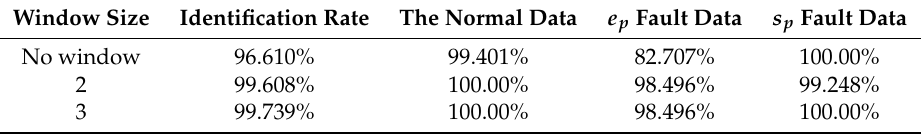
Table 6. The relationship between the sliding window length and fault identification indicators. Window